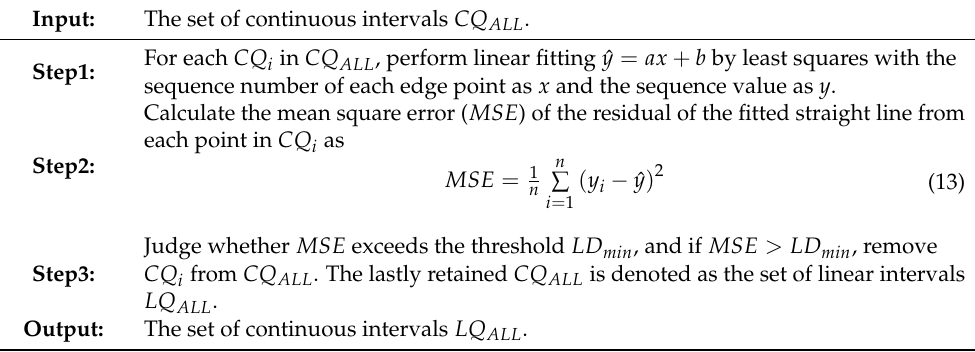
Table 4. Steps of the Linearity Processing.